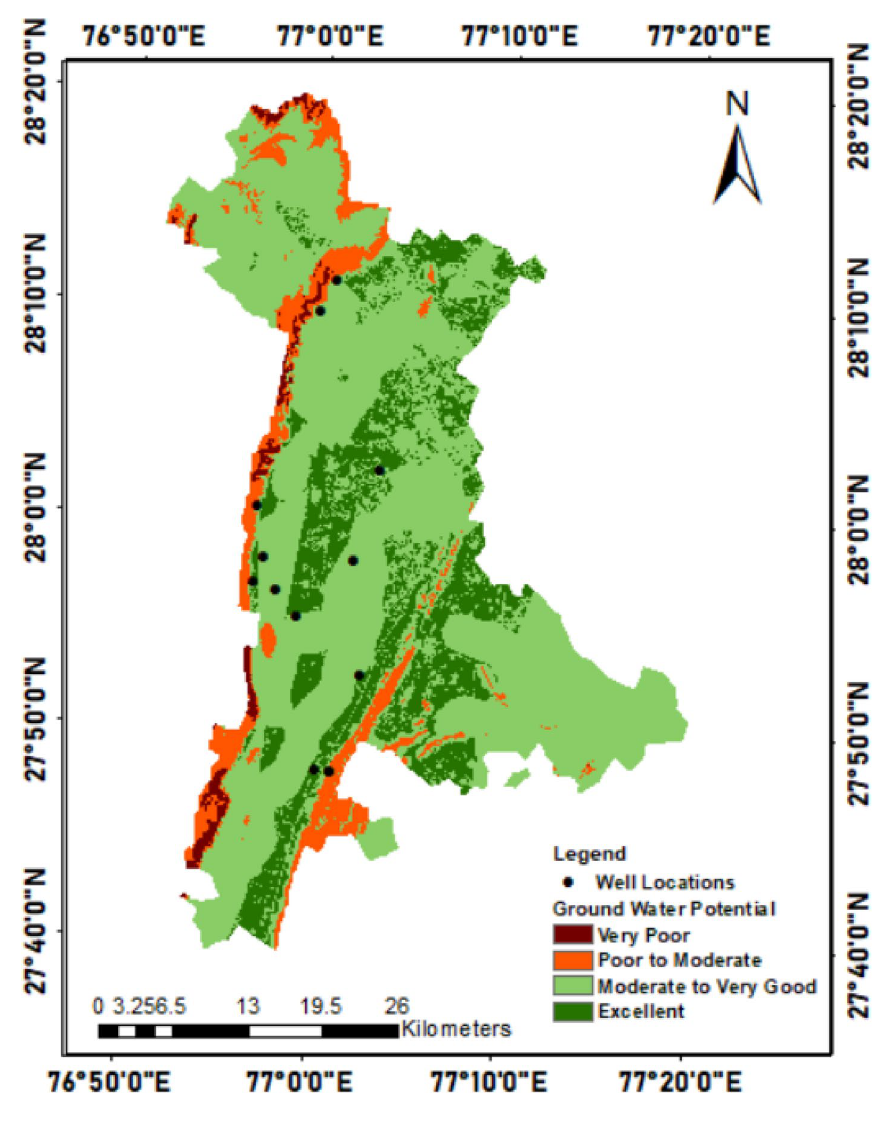
Table 5 Showing coordinates of wells and class of groundwater potential